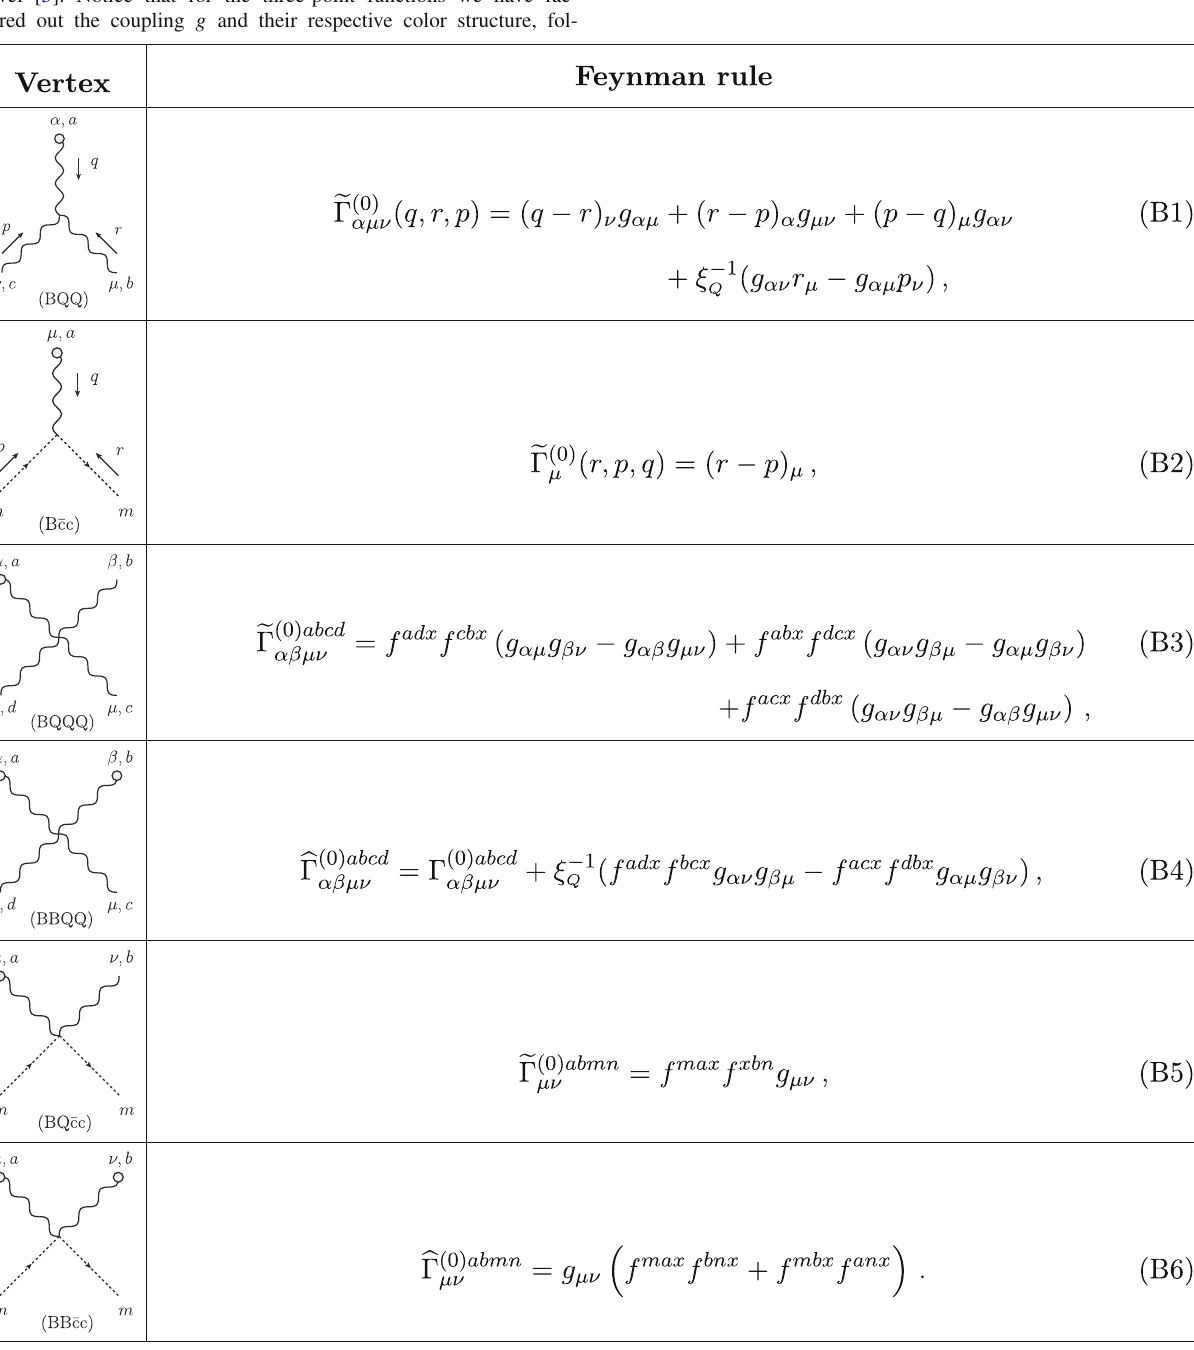
Table 1 The diagrammatic representations of the new vertices appearing in the BFM and their respective Feynman rules at tree level [5]. Notice that for the three-point functions we have fac- tored out the coupling g and their respective color structure,